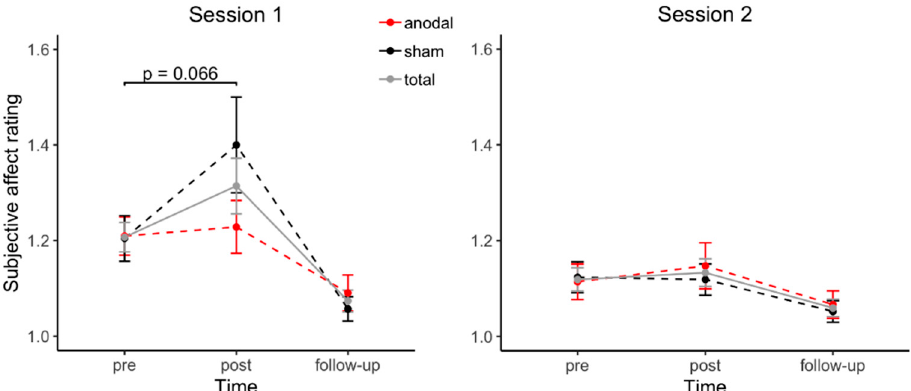
Figure 2. Changes in negative affect during each session with regard to stimulation condition. Subjective rating of negative affect is shown separately for each session in pre- and post-task and follow-up condition. As the order of received stimulation (‘anodal/sham’ or ‘sham/anodal’) was a between-subject factor, participants receiving anodal stimulation during the first session ( n = 21) received sham stimulation during their second session, and vice versa ( n = 21). Error bars depict standard errors of the mean.